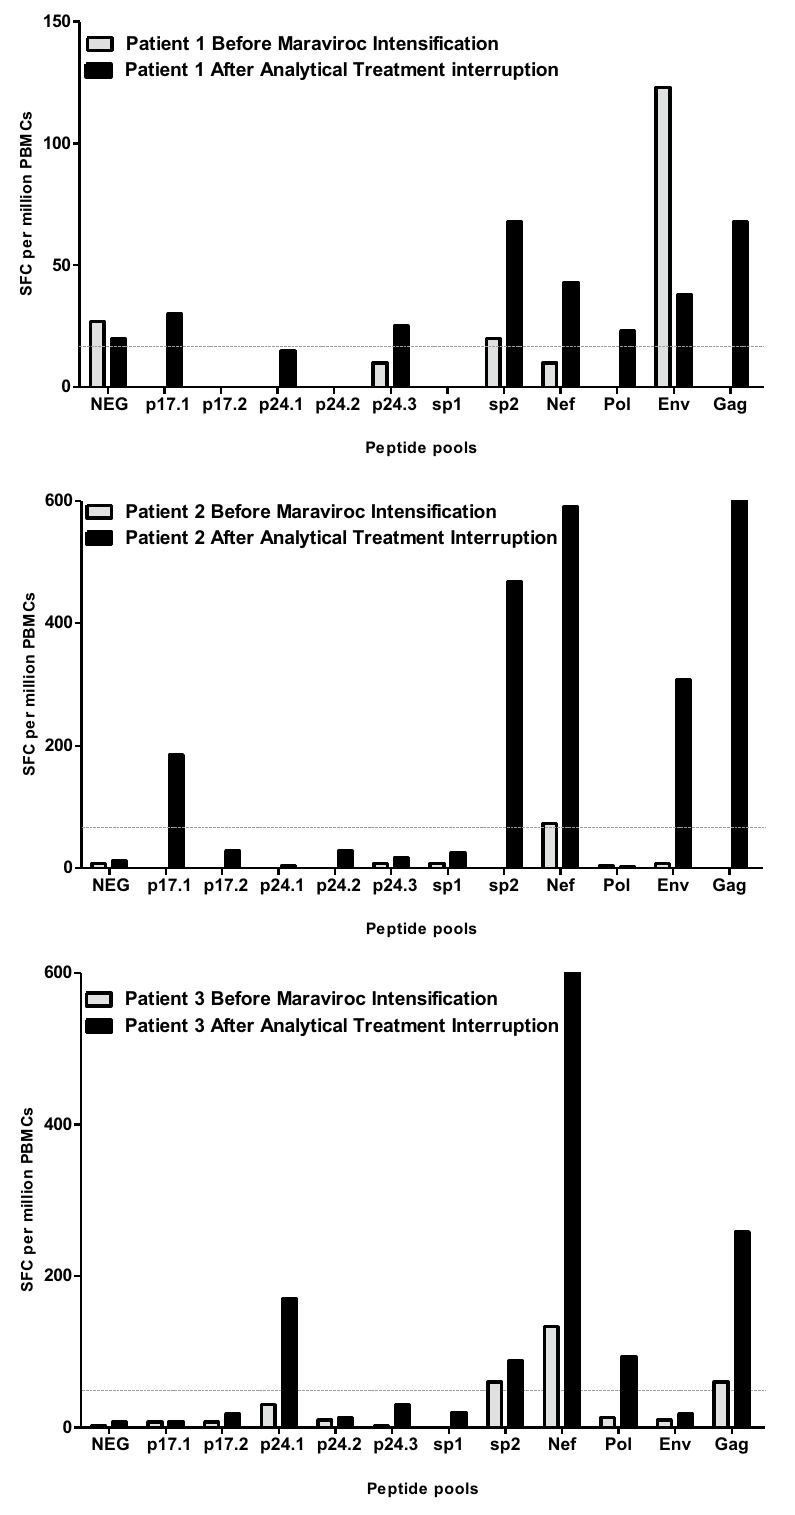
Figure 3. HIV specific T lymphocyte response. The ELISpot assay, that quantifies interferon-γ secretion against different peptide pools covering p17, p24, sp1, sp2, gag, pol, nef and env sequences, was used. Samples were taken before the intensification with maraviroc during the initial study (grey bars) and when antiretroviral treatment was resumed after the ATI during the amended study (black bars). Data are are shown as the number of cells secreting interferon-γ against the indicated peptide per 10 6 peripheral blood mononuclear cells (PBMCs). The dotted grey line indicates the threshold for positivity (50 SFC per million PBMCs). SFC, spot forming